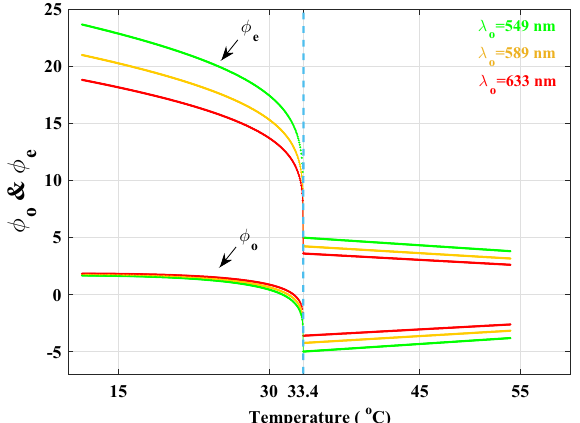
Figure 5. Temperature-dependent variations in the nonlinear behavior of OPD in the nematic phase and the linear behavior in the isotropic phase for wavelengths (cid:31) 0 = 549 (green), 589 (orange), and 633 nm (red). At T C = 33.4 ◦ C, all these curves undergo significant